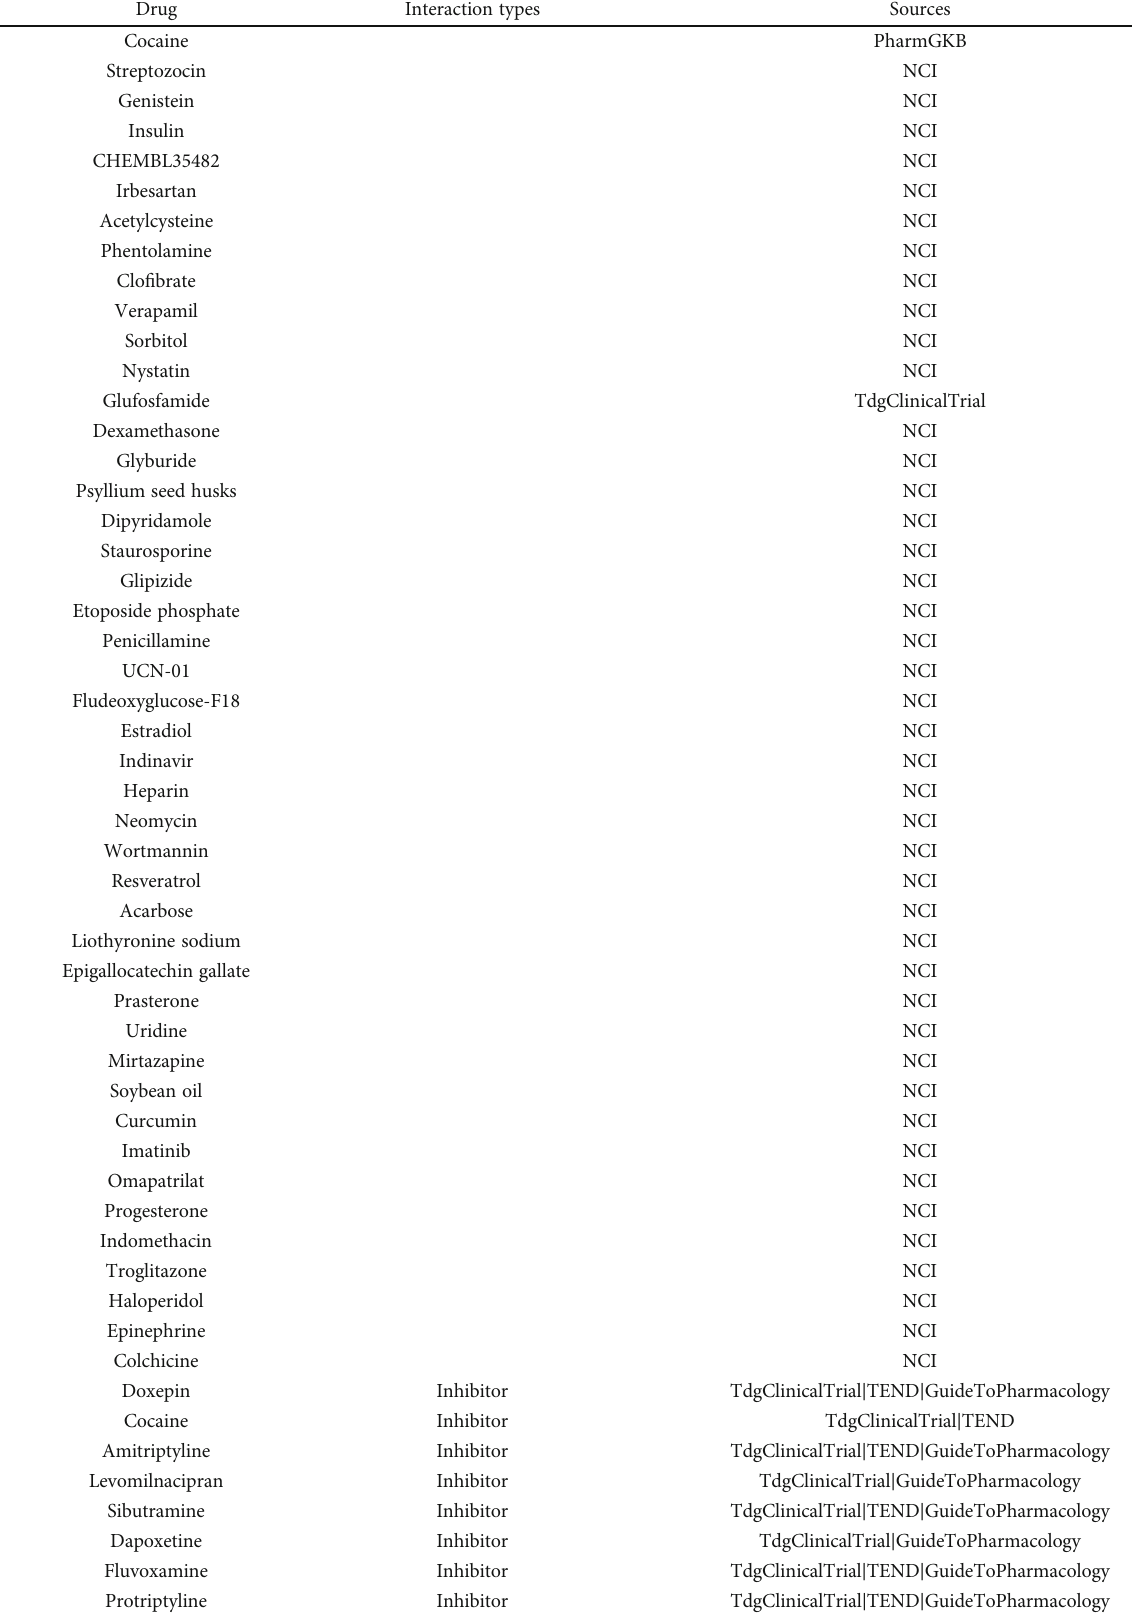
Table 3: Hub gene-drug